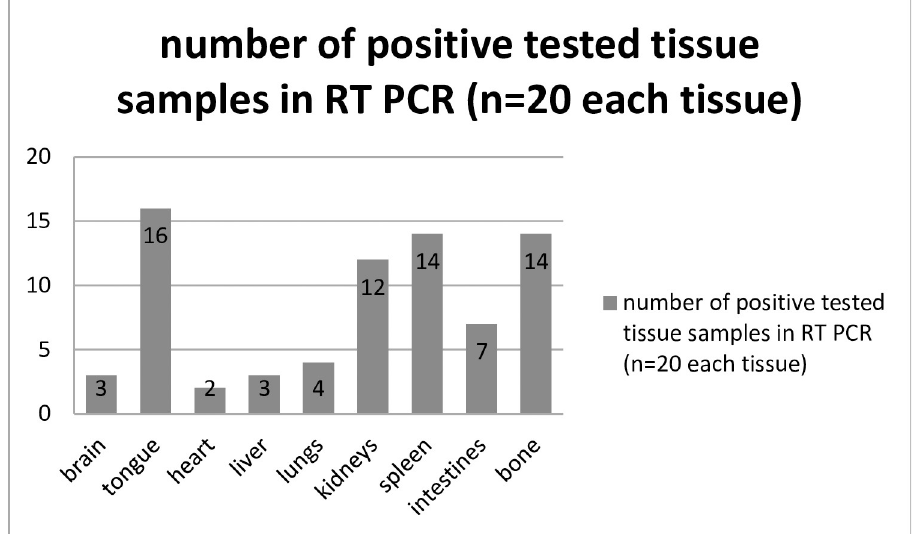
Fig 9. Number of RT PCR positive organ samples collected during necropsy; total number